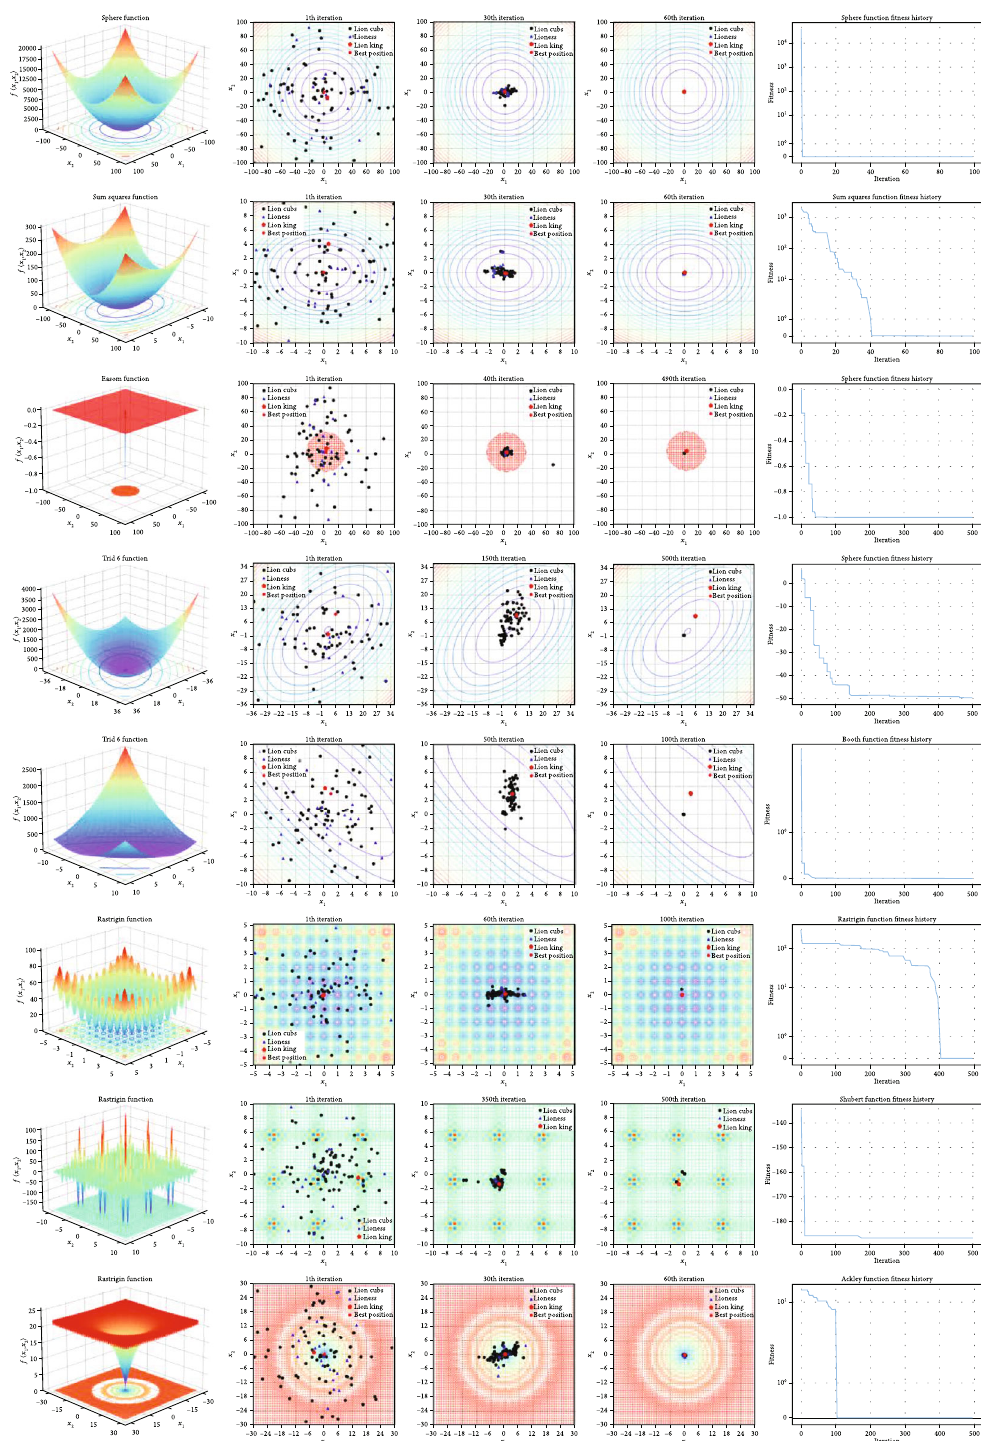
Figure 12: 2D search history and convergence curve of ILSO algorithm on eight